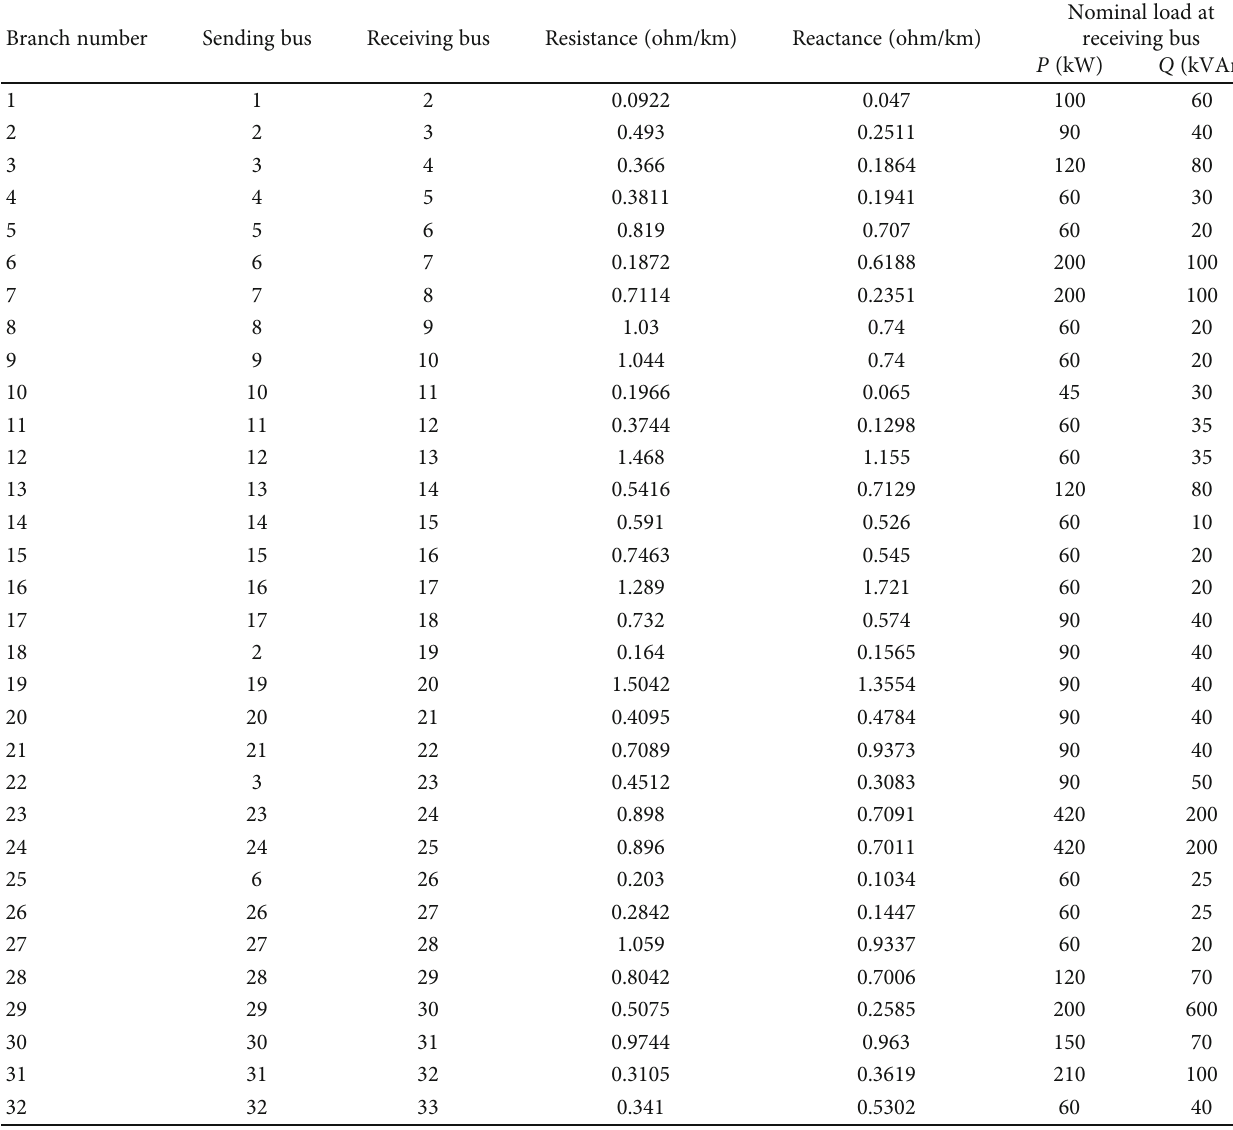
Table 2: Line and load data of an IEEE-33 bus system.